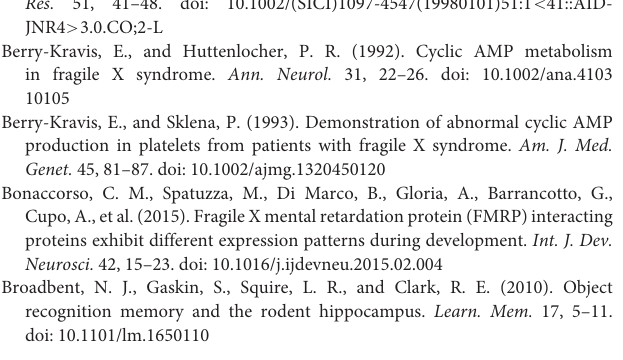
FIGURE S1 | LP-211 treatment increased levels of both phospho-ERK1 and phospho-ERK2 in hippocampal slices of wild-type (WT) mice. (A) Semi-quantitative analysis of phosphorylated ERK1 vs. total ERK1 in control and LP-211 (10 nM, 5 min) treated hippocampal slices from WT mice (FVB strain). Relative optical density is presented as percentage of control. Data represent mean ± SEM of four separate experiments, each performed on a pool of three mice. ∗ p = 0.0286 by Mann-Whitney Rank Sum Test. (B) Semi-quantitative analysis of phosphorylated ERK2 vs. total ERK2 in control and LP-211 treated hippocampal slices from WT mice (FVB strain). Relative optical density is presented as percentage of control. Data represent mean + SEM of four separate experiments, each performed on a pool of three mice. ∗ p = 0.0412 by unpaired t -test. FIGURE S2 | Original images of immunoblots shown in Figure 5A . FIGURE S3 | (A) Original images of immunoblots shown in Figure 5B . (B) Original images of immunoblots shown in Figure 5C . FIGURE S4 | Experimental procedures for marble burying test. Marbles distribution before testing shows twenty marbles equidistantly distributed. Mice were left in the cage for 20 min and number of buried marbles was analyzed in four different groups (vehicle-treated WT; WT treated with LP-211; vehicle-treated Fmr1 KO; Fmr1 KO treated with